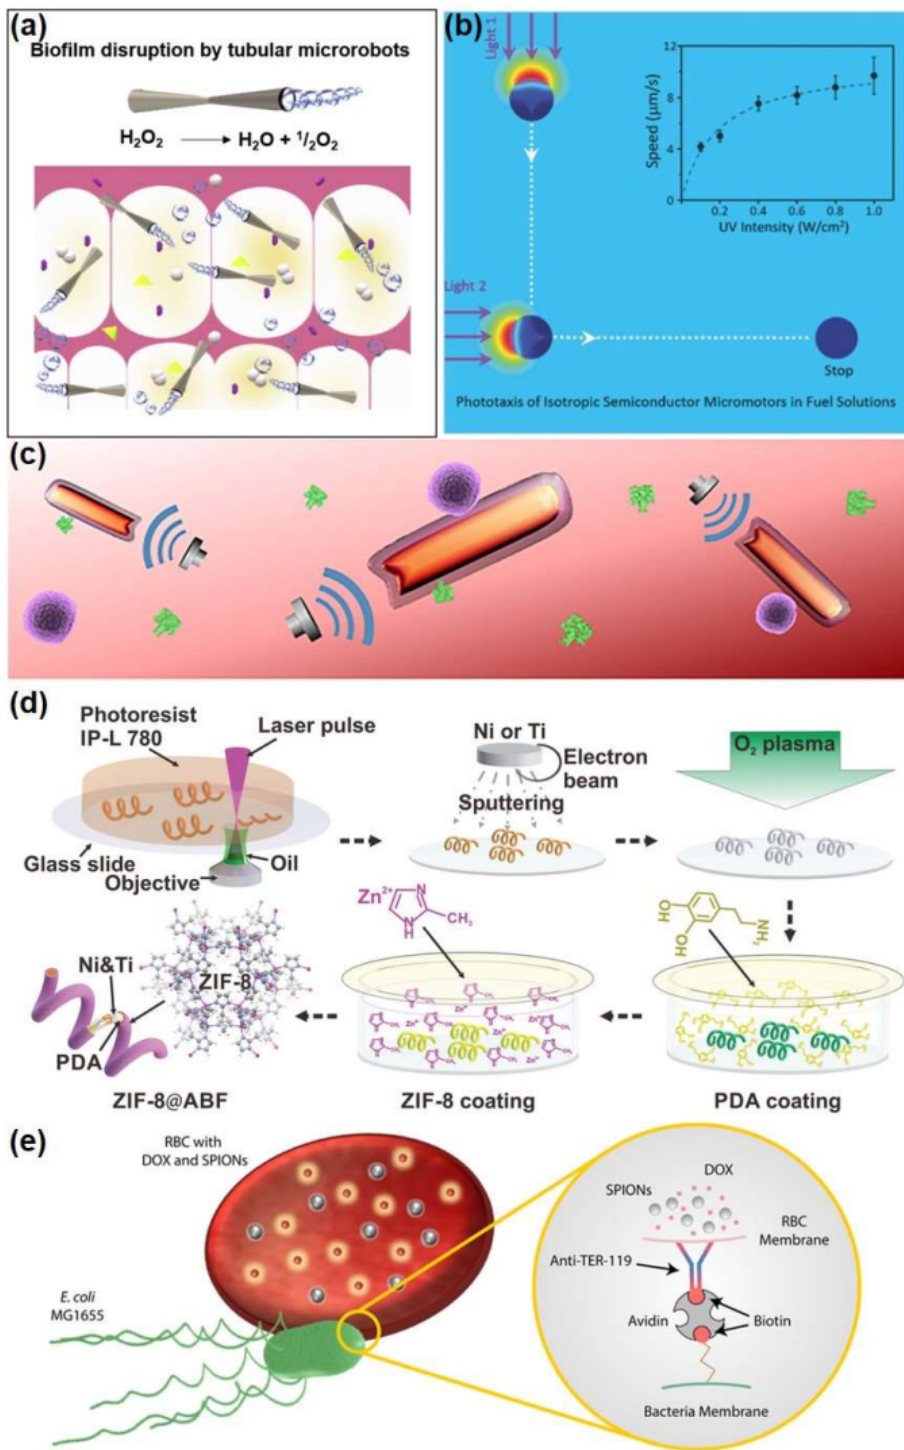
Figure 2. Different driving mode of micro/nanorobots. ( a ) Self-propelled microbots with high antibacterial activity for the degradation of dental biofilm [19], copyright 2020, Elsevier; ( b ) a disrup- tive strategy to design micromotors by using isotropic structures [24], copyright 2016, Wiley-VCH; ( c ) schematic of biomimetic robots for binding and removal of threatening biological agents [27], copyright 2018, American Association for the Advancement of Science; ( d ) schematic illustration of the component steps involved in the manufacture of ZIF-8@ABF microrobots [30], copyright 2019, Wiley-VCH; ( e ) RBC microswimmers for active cargo delivery, copyright 2018,